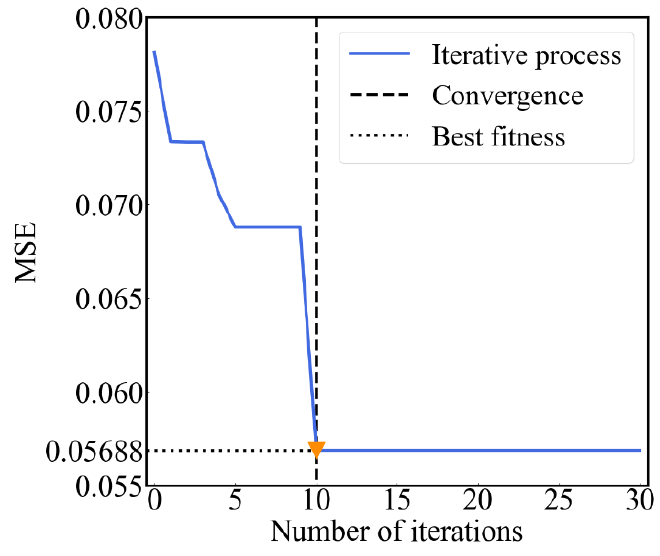
Figure 6. Iterative process of SSA.